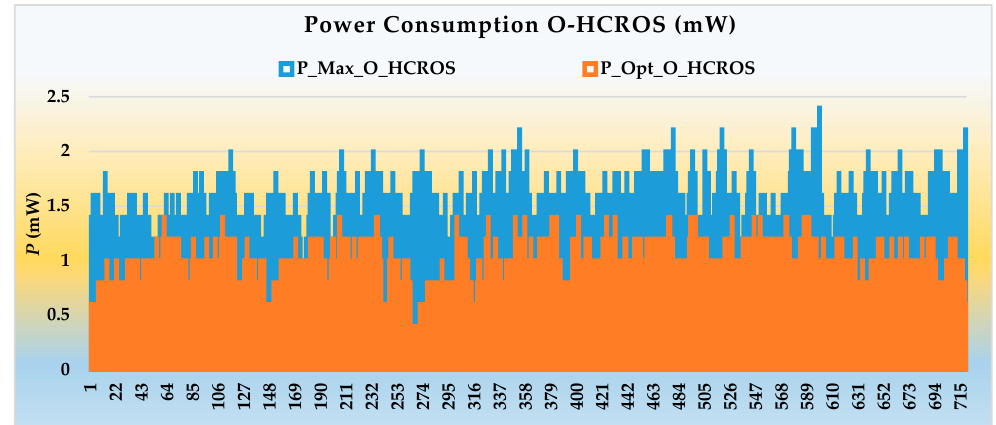
Figure 13. Power consumption P Max_O_HCROS and P Opt_O_HCROS for all 720 I/O links in optimized HCROS .